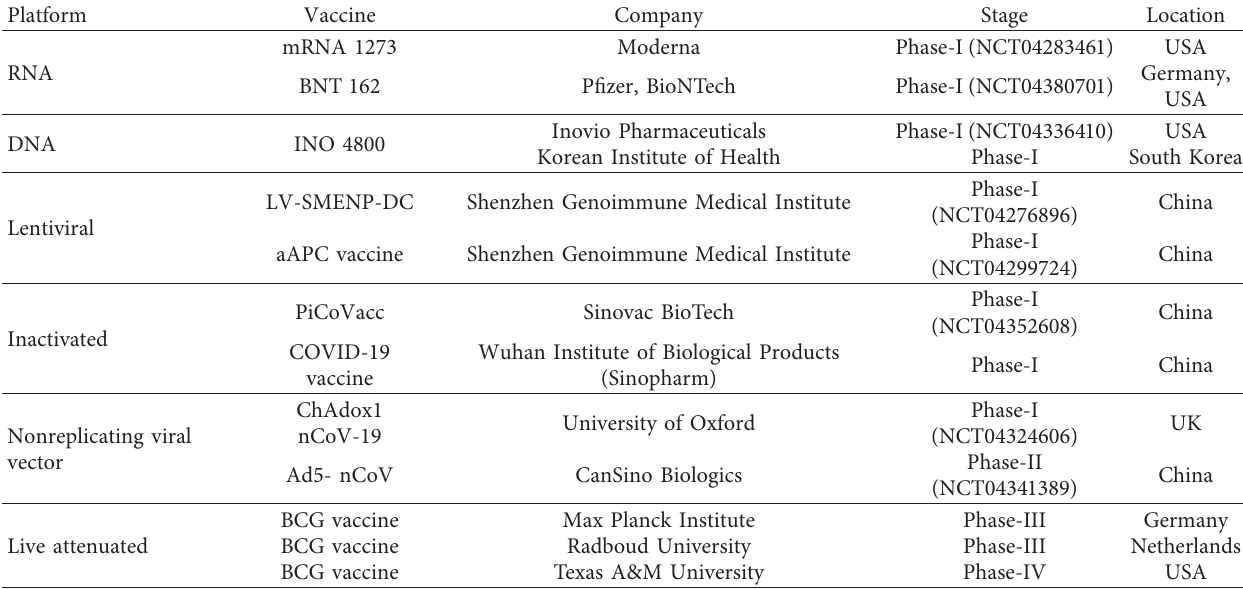
Table 3: Notable COVID-19 vaccine candidates in clinical